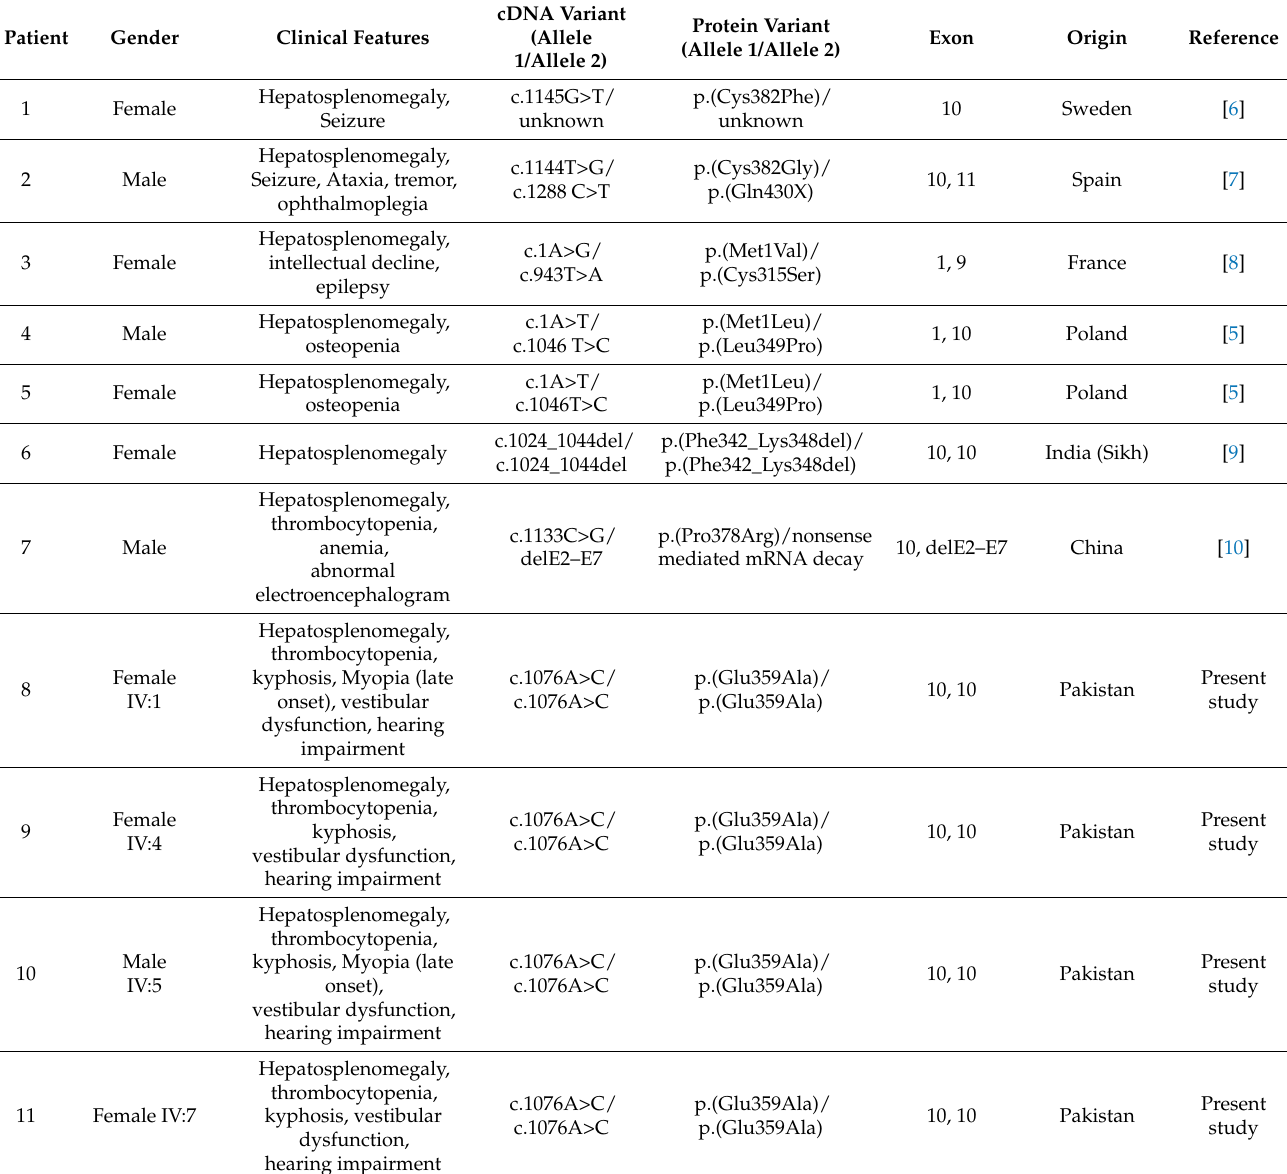
Table 1. Overview of Gaucher disease patients with saposin C